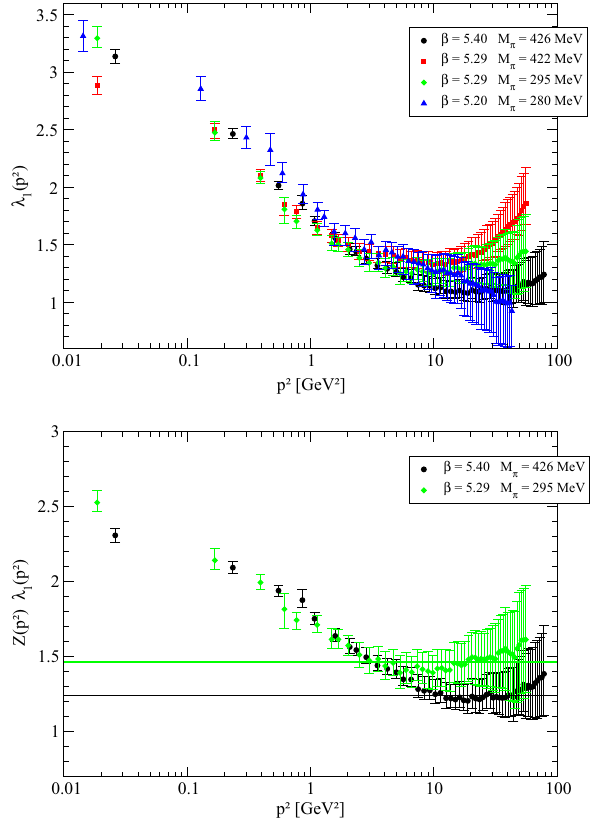
Fig. 2 Tree level corrected lattice data from the full QCD N f = 2 lattice 32 3 × 64 simulations for λ 1 ( p 2 ) in the Landau gauge [18] (top- frame). Z ( p 2 )λ 1 ( p 2 ) as a function of p 2 (bottom-frame). See text